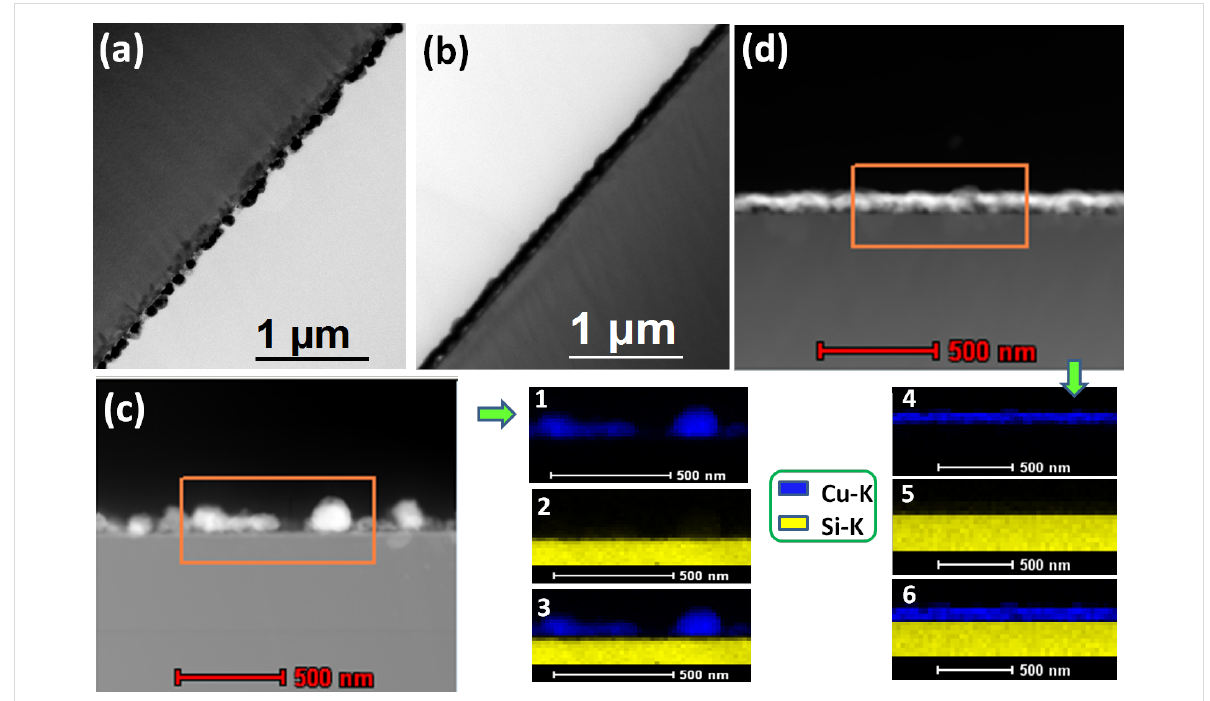
Figure 4: (a),(b) Cross-sectional bright field TEM images and (c),(d) STEM-HAADF images of as-deposited and annealed at 500 °C in oxygen ambient copper nanoparticles on silicon substrates, respectively. The elemental mapping of Cu (1 and 4), Si (2 and 5), and the composite thereof (3 and 6) collected from the orange rectangular region of STEM-HAADF images (c) and (d),